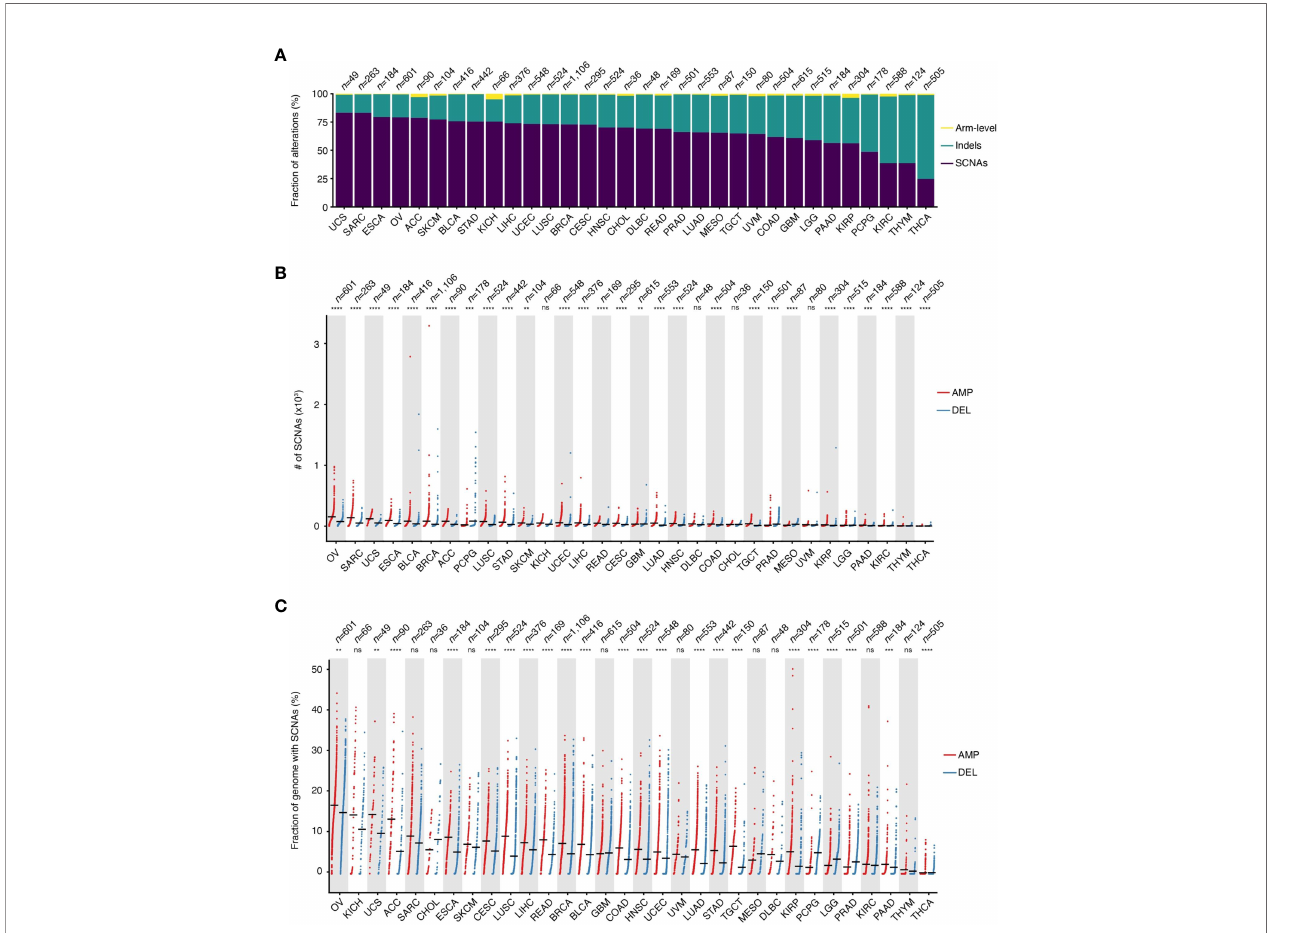
FIGURE 1 | Prevalence of SCNAs across different tumor types. (A) Percentage of arm-level aneuploidies, indels and SCNAs by tumor type. (B) Number of SCNAs by tumor type, separately for ampli fi cations (AMP) and deletions (DEL). Each dot represents one tumor sample. Black horizontal bars: mean values. (C) Same as in (B) but considering the percentage of the reference genome either ampli fi ed or deleted in each tumor. n , number of samples analyzed for each tumor type. In (B, C) , asterisks indicate statistical signi fi cance levels (Wilcoxon ’ s test, two-sided) at 0.05 (*), 0.01 (**), 0.001 (***) and 0.0001 (****). ns, not statistically signi fi cant. See Supplementary Table 4 for the list of tumor type abbreviations